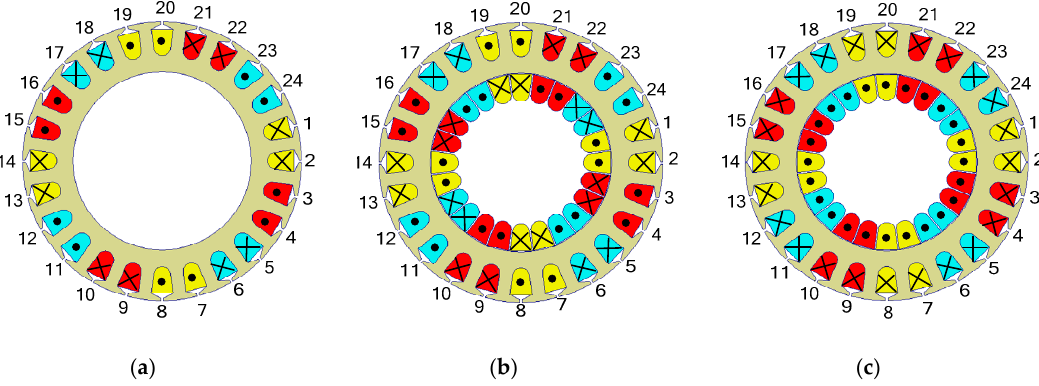
Figure 2. Diagrammatic sketches of stator structure: ( a ) T-PMSM; ( b ) T-TWPMSM; ( c ) N-TWDDPMSM.